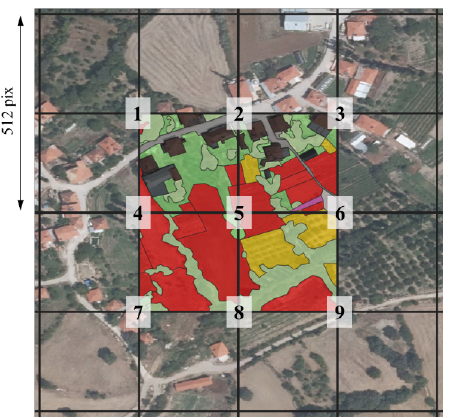
Figure 7. Illustration of data augmentation by using additional image-context. One annotated patch now becomes nine patches (numbers are located in the centre of a